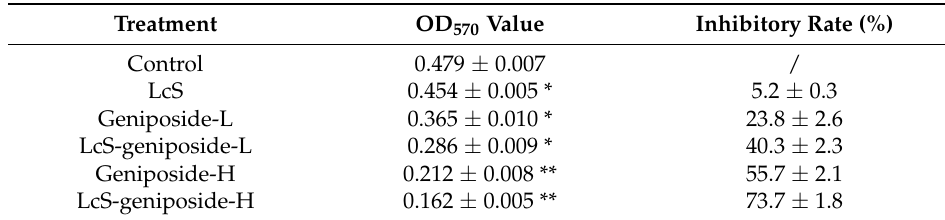
Figure 2. Effects of Lactobacillus casei strain Shirota (LcS) ( A ) and geniposide ( B ) on the growth of human oral squamous carcinoma HSC-3 cells. Table 1. Growth inhibition of human oral squamous carcinoma HSC-3 cells by Lactobacillus casei strain Shirota (LcS) and geniposide by an MTT